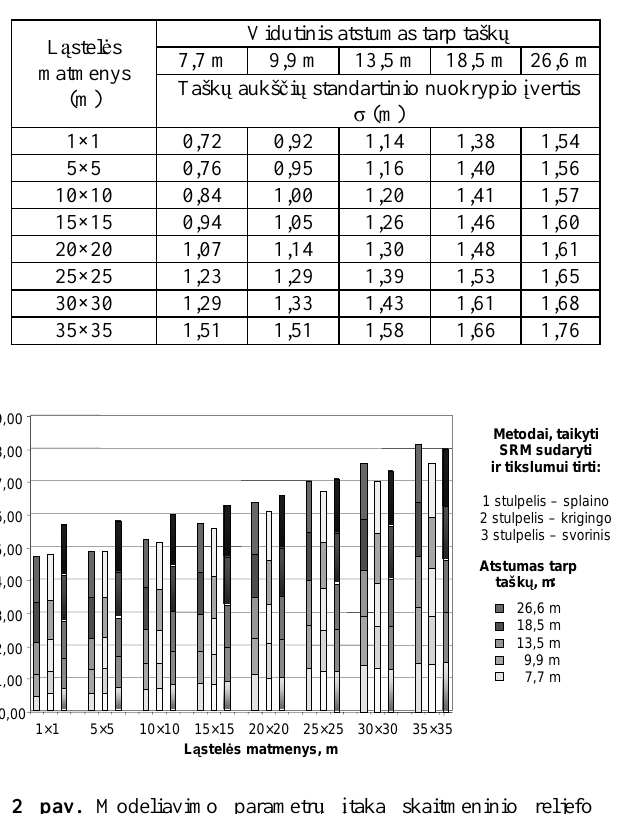
Fig 2. Influence of modelling parameters on the accuracy of DTM, using different methods Kaip matyti iš 2 pav., dauguma stulpeli ų grupi ų tiksliausiai gauta krigingo metodu.